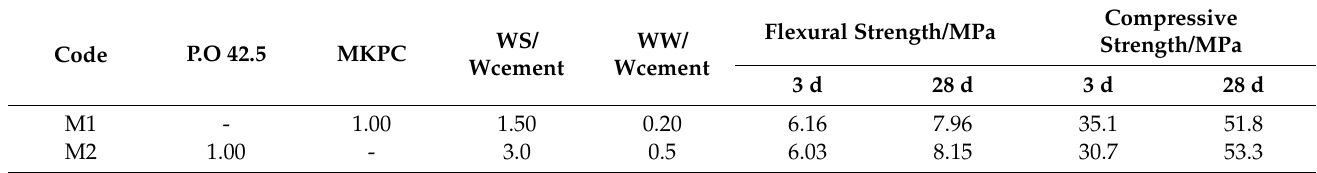
Table 2. Mixing ratio of MKPC